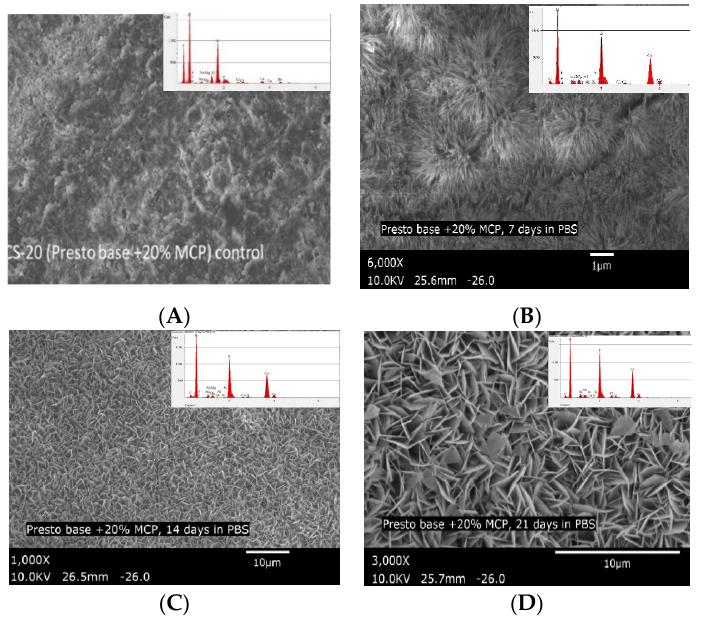
Figure 8. ( A ) SEM micrograph of specimen containing 20 wt.% MCP (CS-20) before immersion in PBS, and SEM micrograph and EDS of specimen after 7 days ( B ); 14 days ( C ); and 21 days ( D ) of immersion in PBS.